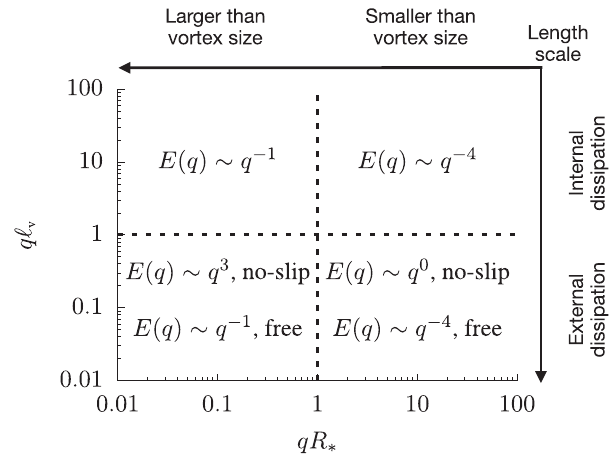
FIG. 6. Scaling regimes of turbulent flows in an active nematic film in contact with an external fluid. The different regimes are predicted at length scales ( ∼ 1 =q ) either larger or smaller than the mean vortex radius R (cid:2) , the viscous length l v ¼ η n = η thickness H of the external fluid layer. This figure summarizes the scalings in the thin-layer limit qH ≪ 1 ; see the main text and Fig. 2 for the predictions in the thick-layer limit qH ≫ 1